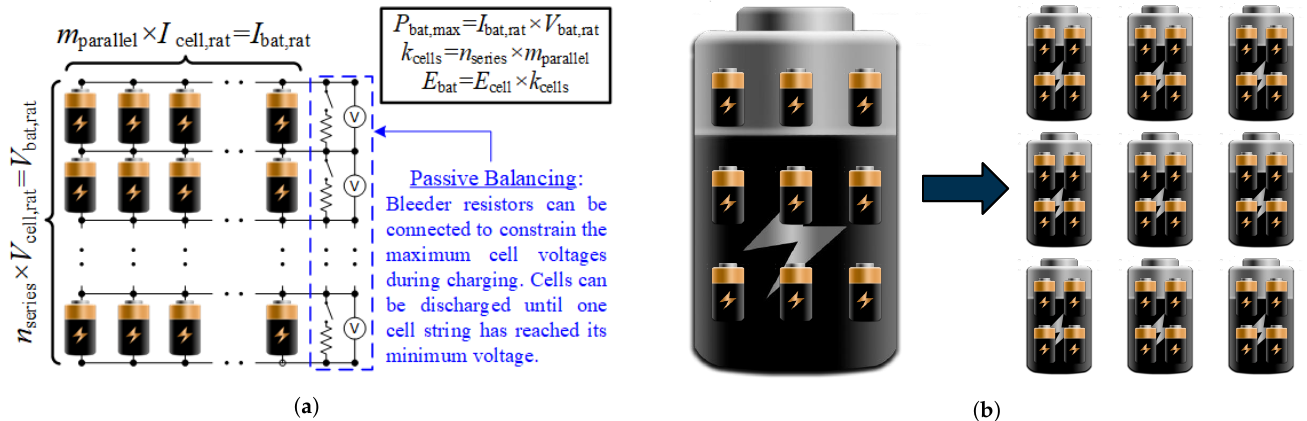
Figure 1. ( a ) Overview of a generic battery pack utilizing passive balancing and ( b ) modular battery system consisting of small, generic battery